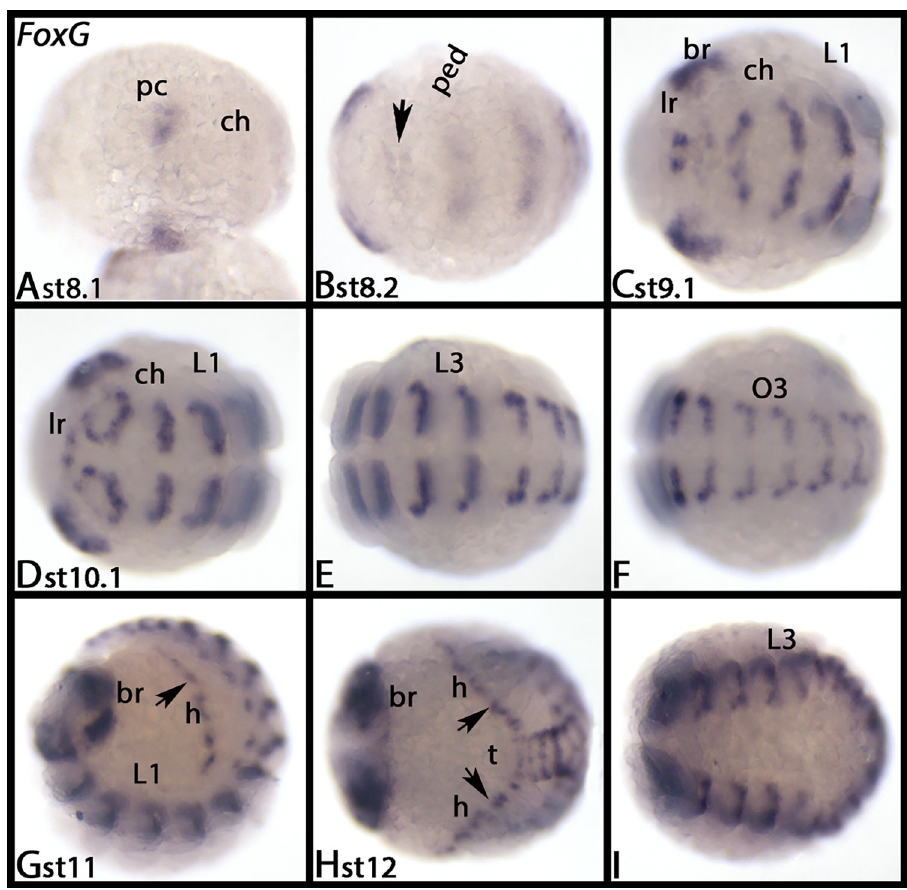
Fig 11. Expression of Parasteatoda FoxG . In all panels, anterior is to the left, ventral views, except panels G, lateral view and H, dorsal view. Each row (except first row, A-C) represents the same embryo. Arrow in panel B marks weak expression in the chelicerae segment. Arrows in panels G and H point to the heart. Abbreviations in Table 2. DAPI staining of the embryos shown in this figure are presented in S13